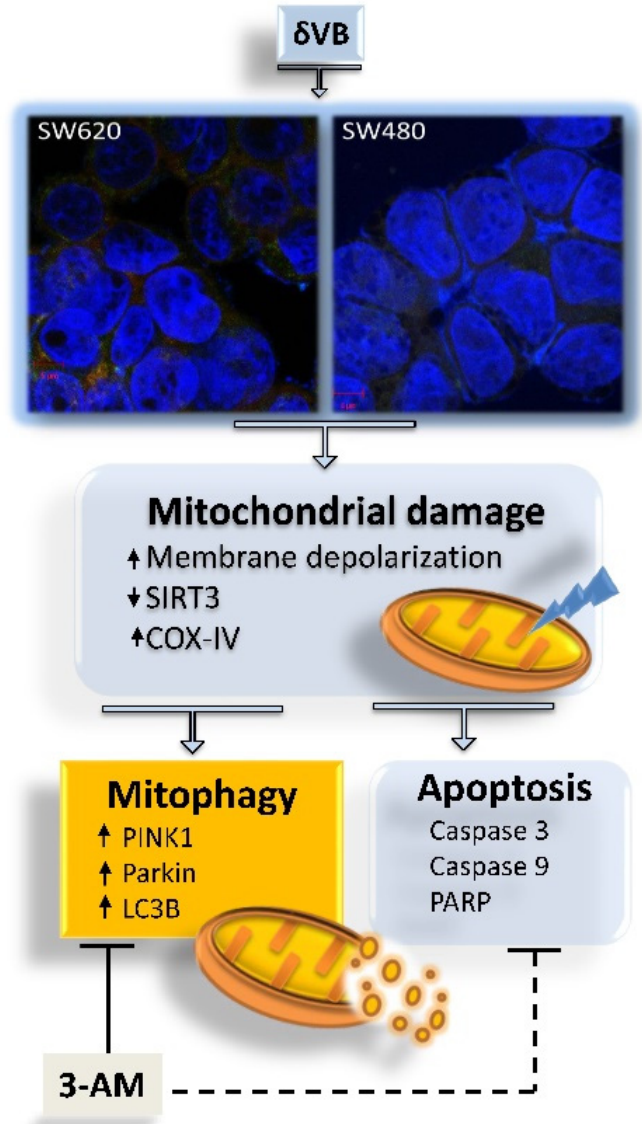
Figure 8. Proposed cellular events leading to colorectal cancer apoptosis induced by δ VB. Evidence from the present study suggest that mitochondrial dysfunction and downregulation of SIRT3 induced by δ VB fueled the mechanism of mitophagy, which in turn triggered cell death by apop- tosis, as evidenced by the inhibition of mitophagy with 3-AM which resulted in the attenuation of intrinsic